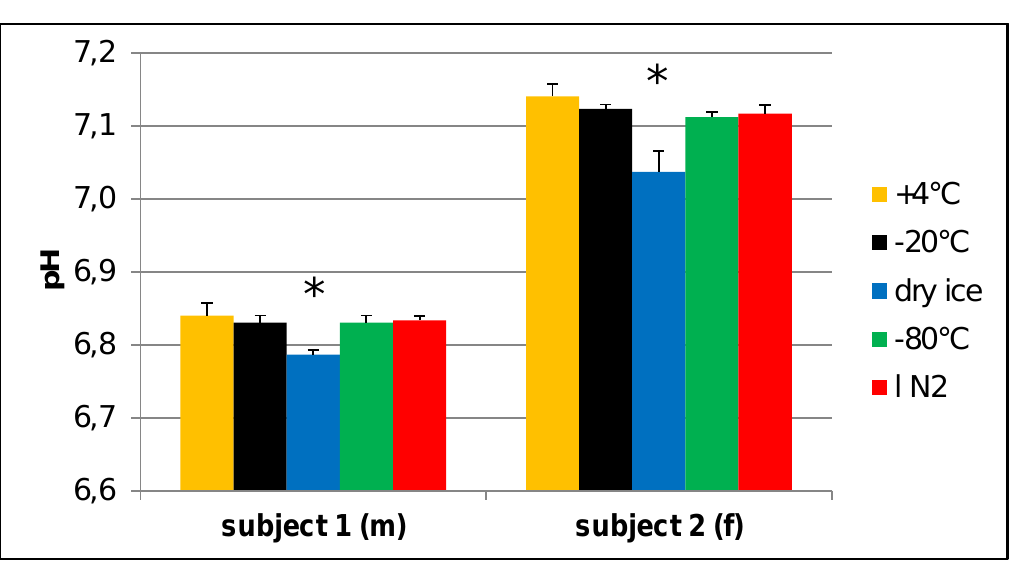
Figure 5. Effect of freezing on pH of urine samples. pH values were determined in buffered urine samples with a final concentration of 150 mM phosphate buffer after NMR experiments. Samples that were frozen on dry ice have a significantly different pH compared to all other samples of the same volunteer. N = 3, values given as the mean + SD; * p < 0.05 vs. all other samples of the same subject (one-way